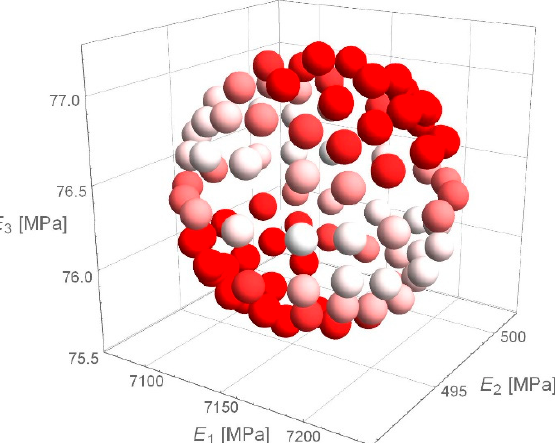
Figure 9. e RMS error for individual combinations of material parameters—spherical domain.